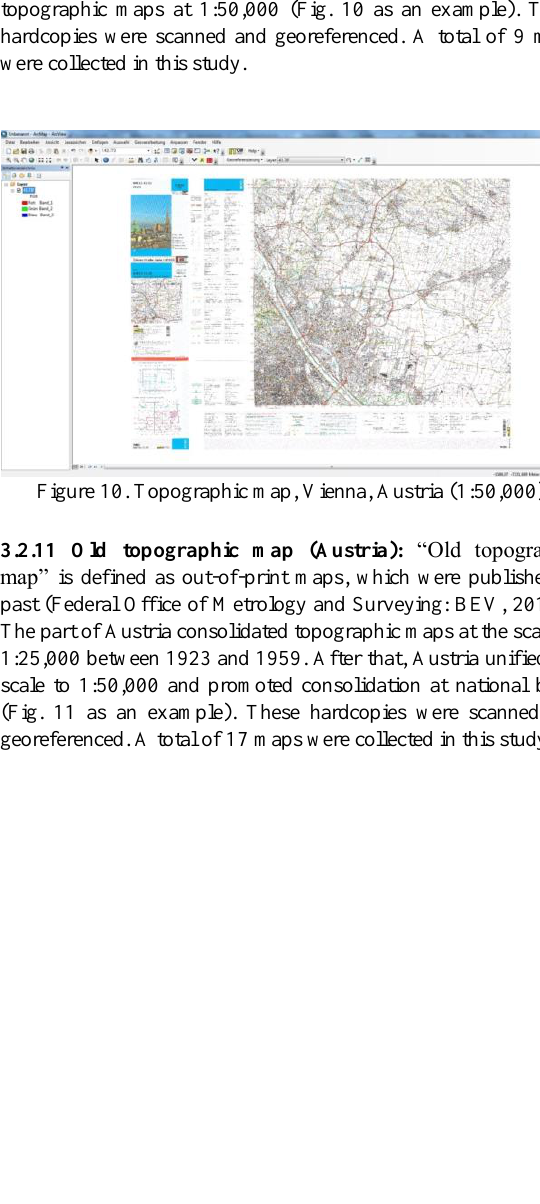
Figure 11. Old topographic map, Vienna, Austria (1:50,000)